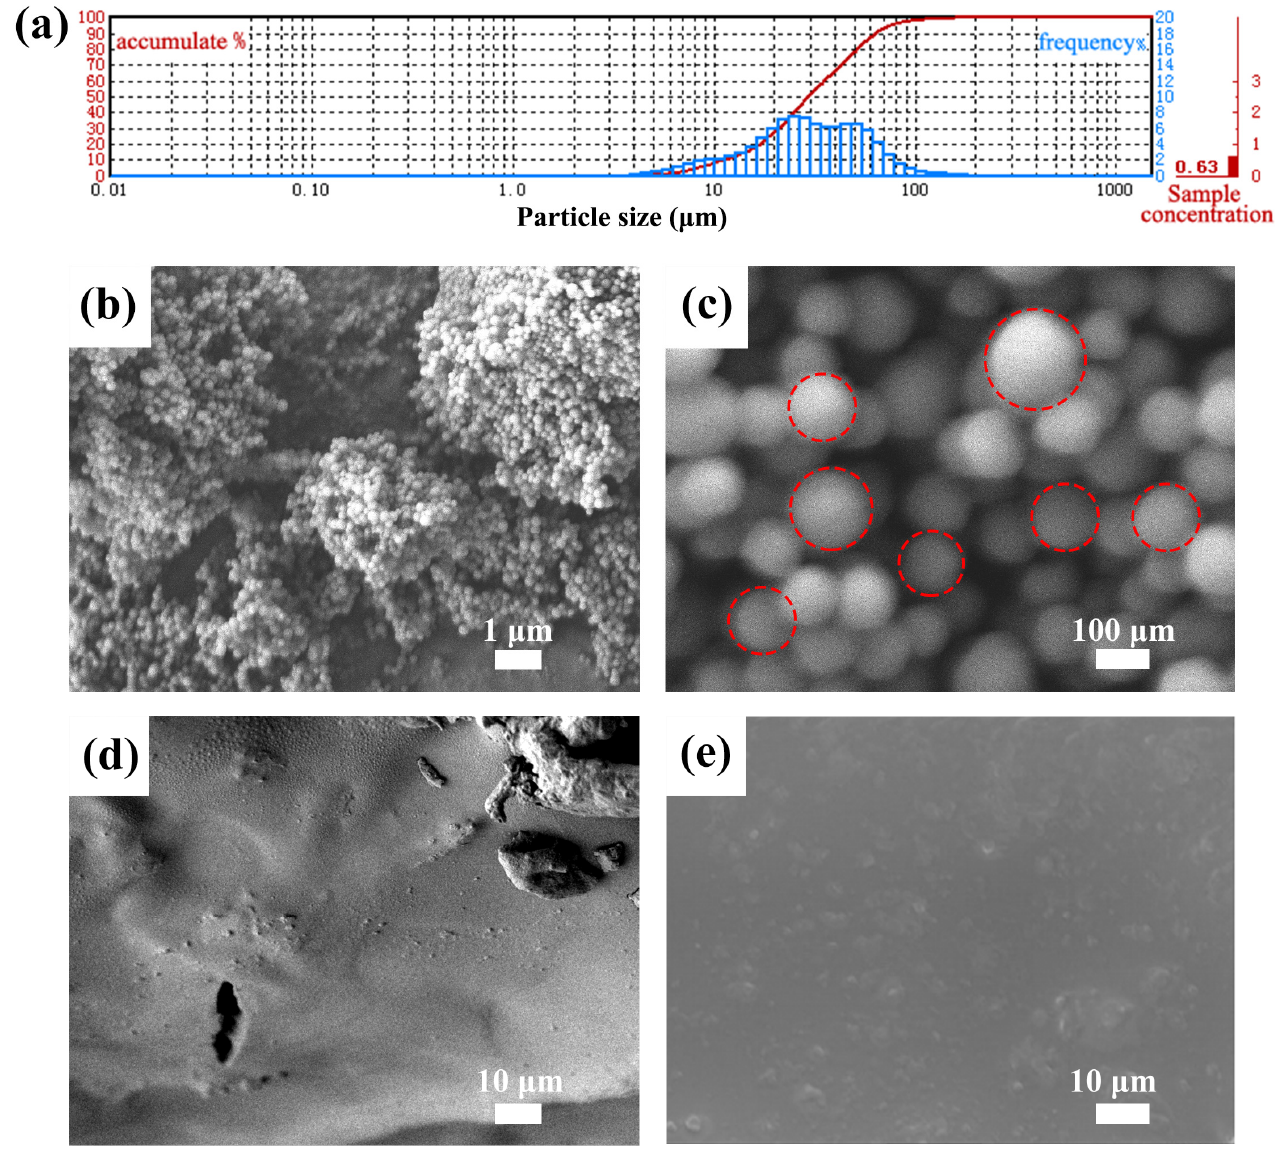
Figure 2. ( a ) Particle size distribution of silica sol, ( b , c ) SEM images of silica sol, UV-curable WA coatings before ( d ) and after ( e ) being reinforced by silica sol.